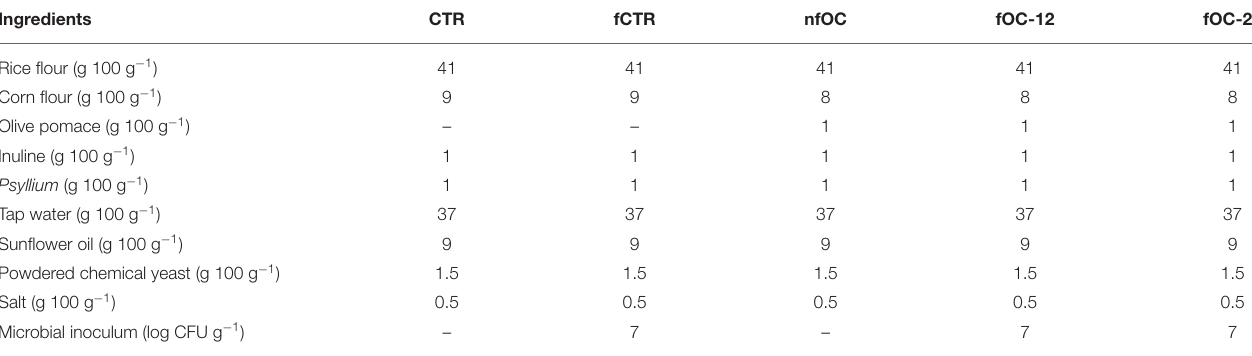
TABLE 1 | Ingredients used for the gluten-free breadstick formulation. Ingredients CTR